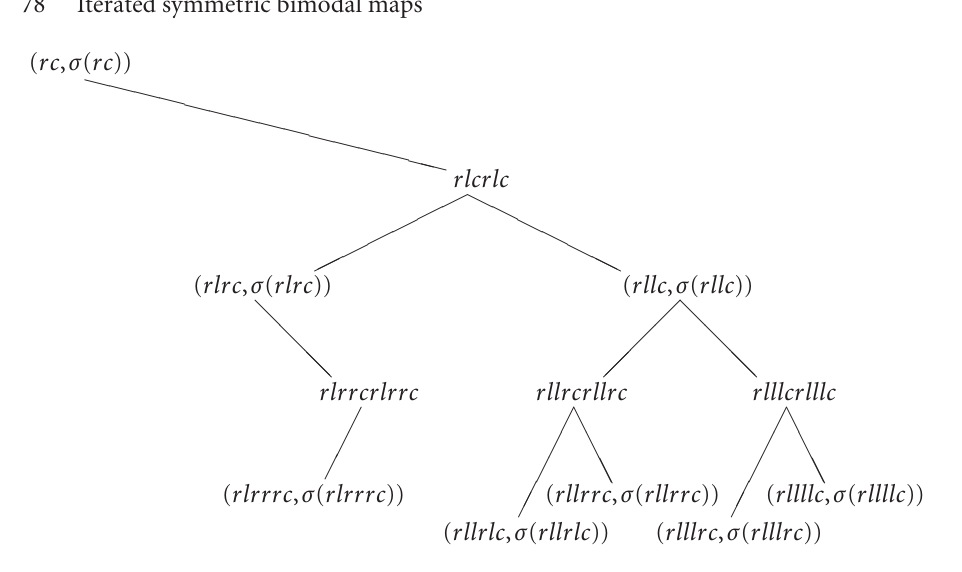
Figure 3.2. The tree (cid:1) .